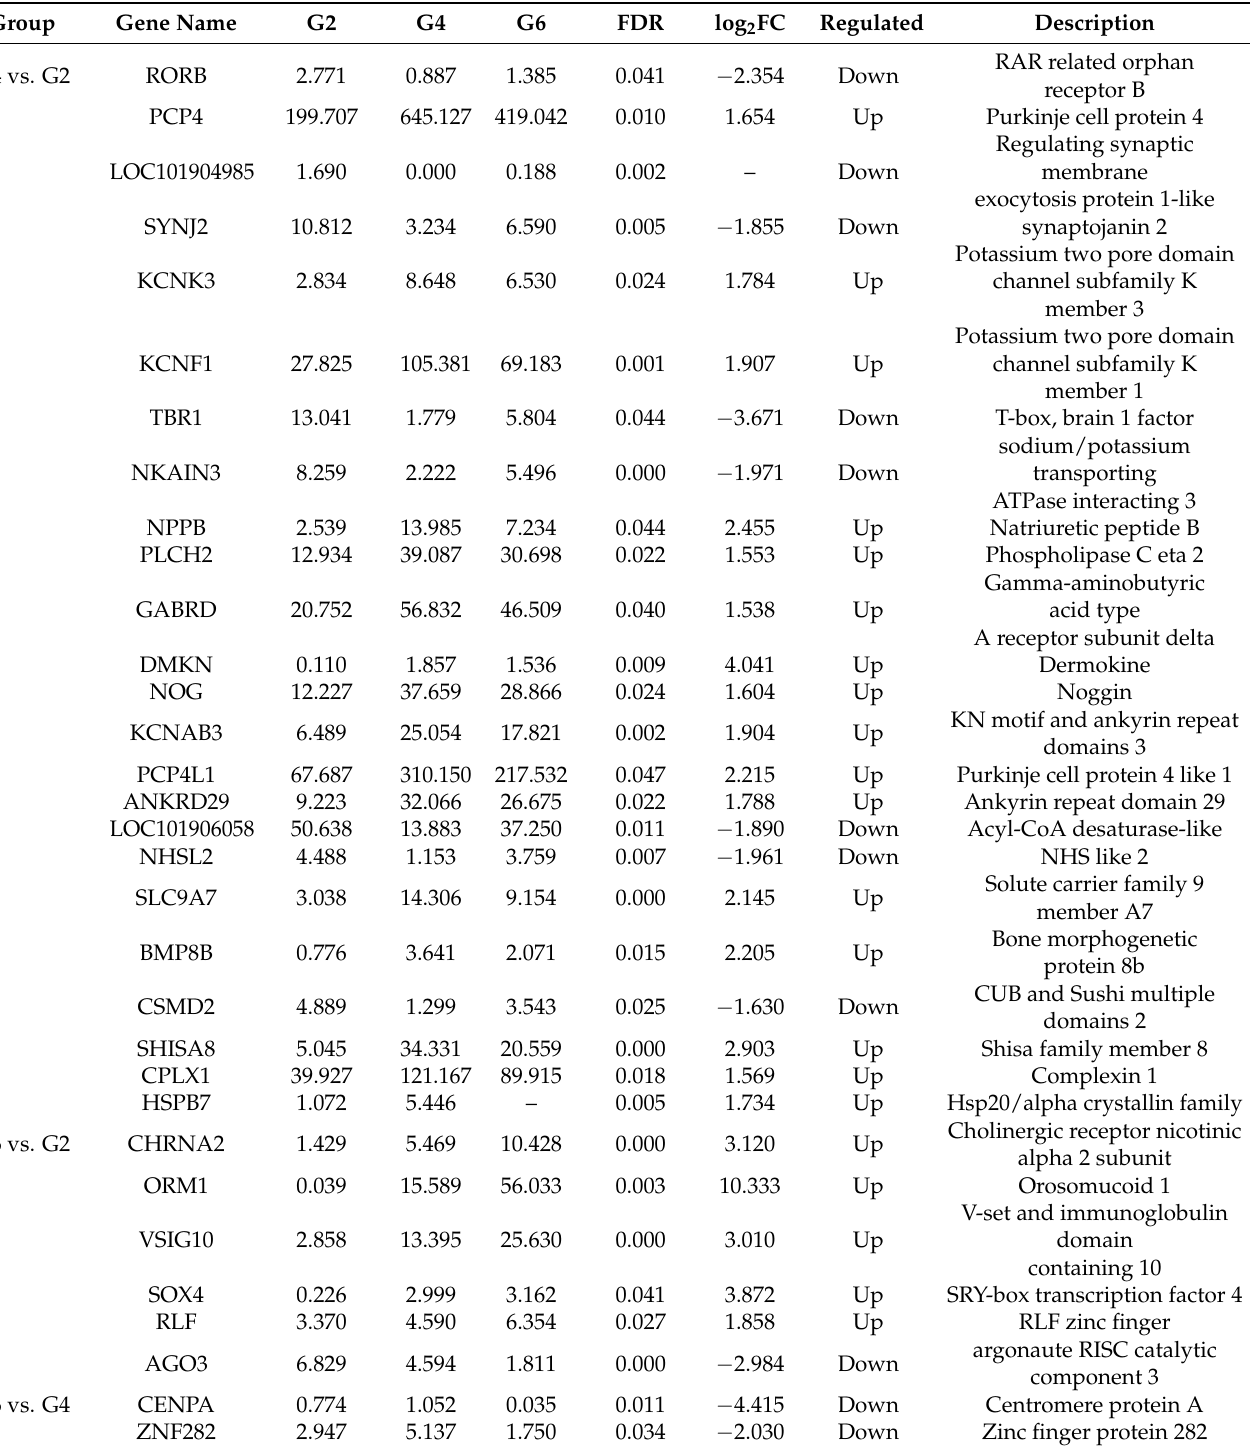
Table 4. Other major differentially expressed genes in hypothalamus (G2, G4, and G6 = 6-month-old, 18-month-old, and 30-month-old Angus cattle